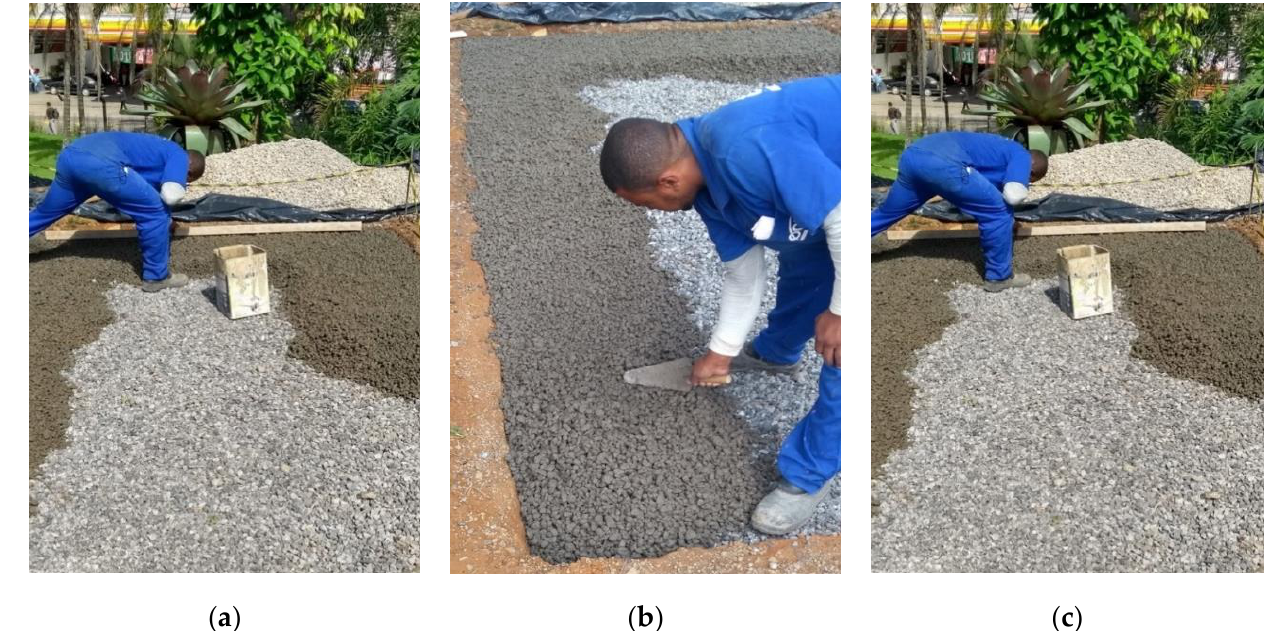
Figure 5. Launch ( a ), compaction ( b ), and levelling ( c ) of the pervious concrete moulded “in situ”.